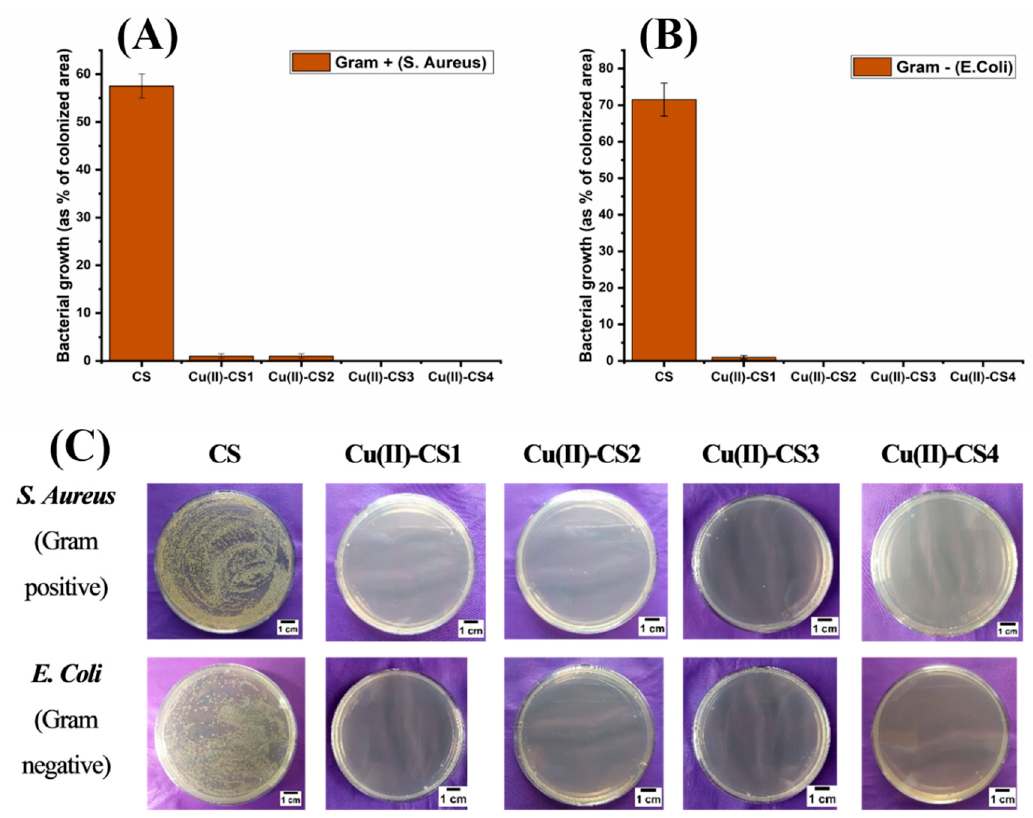
Figure 10. Bacterial growth as % of colonized area: ( A ) Staphylococcus aureus and ( B ) Escherichia Coli . ( C ) Optical Images of recultivated bacterial colonies on agar after 3 h of incubation for the different samples investigated.